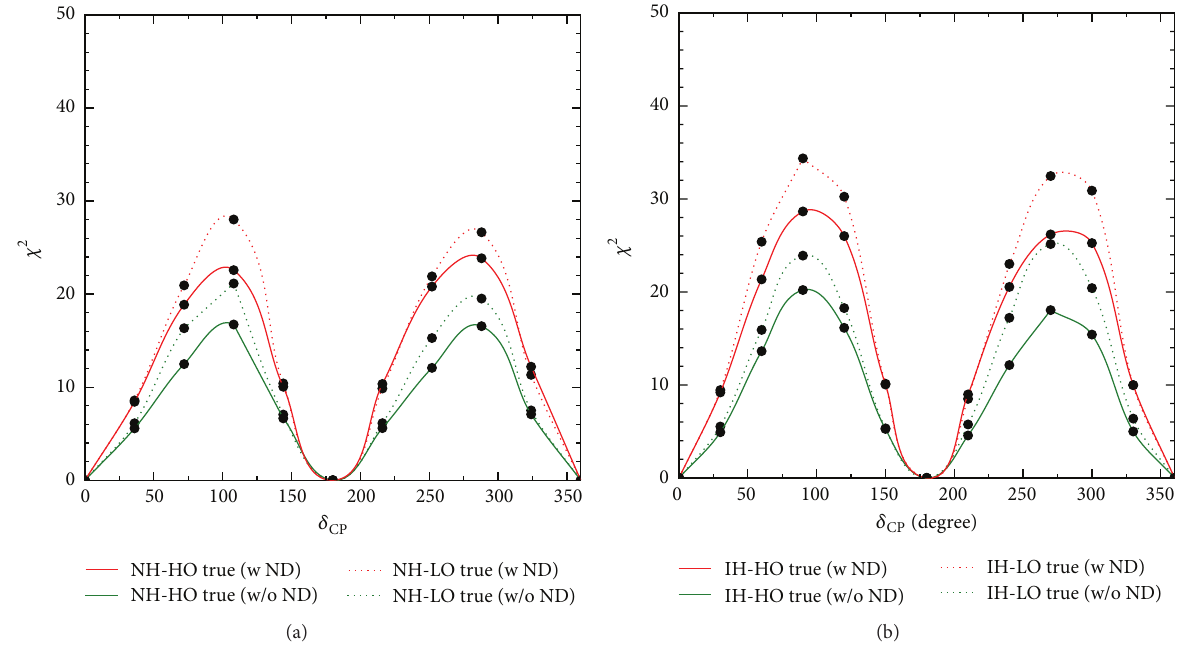
Figure 2: In (a) and (b) 𝛿